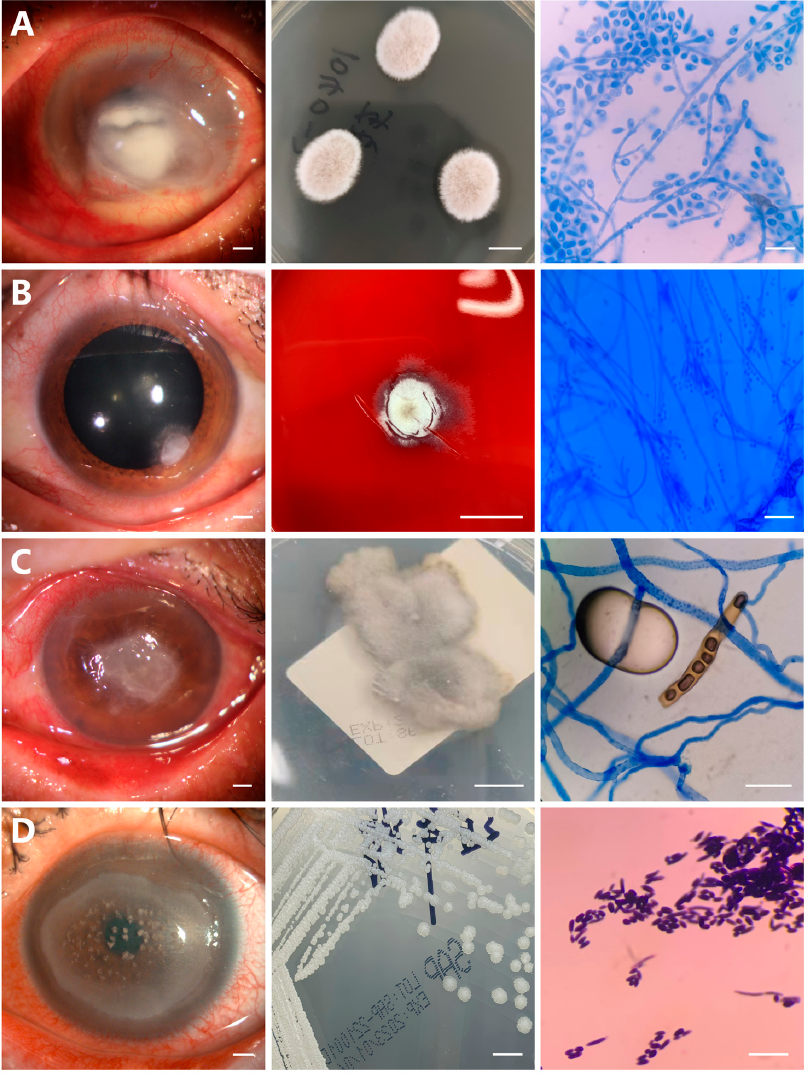
Figure 2. Anterior segment photography, colonies morphology, and lactophenol blue staining of microscopic characteristics of fungal culture species. ( A ) Scedosporium apiospermum colonies are white at the edges and olive-green umbrella-like at the center, flat, spreading, wooly colonies, and microscopic examination shows hyphae with elongated meridiangium and large end apical. ( B ) Paecilomyces lilacinus colonies are white to lilac in color and a floccose aerial mycelium, and micro- scopic examination shows long chains with small round to fusiform conidia. ( C ) Exserohilum species colonies are white in the center and brown surrounding feather appearances, microscopic examina- tion shows numerous decolorized fungi with lack of color and Exserohilum rostratum . ( D ) Candida species are smooth, glossy, raised, cream-colored colonies and microscopic examination shows a purple fusiform appearance with pseudohyphae. (Scale bars = 1 mm in the left; 1 cm in the middle; 50 µ m in the right